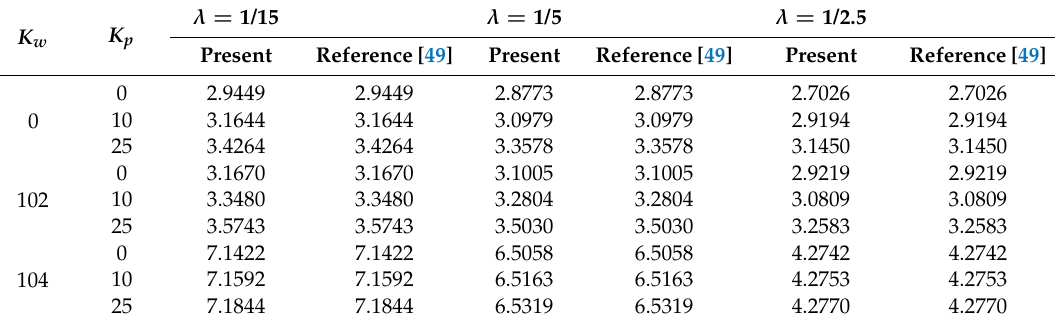
Table2. Comparisonsofthefundamentalfrequencyparameter (cid:36) ofanFGMbeamonelasticfoundations. K w